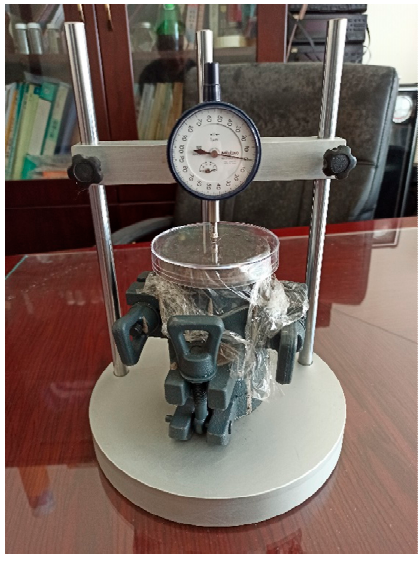
Figure 1. The expansion test instrument.